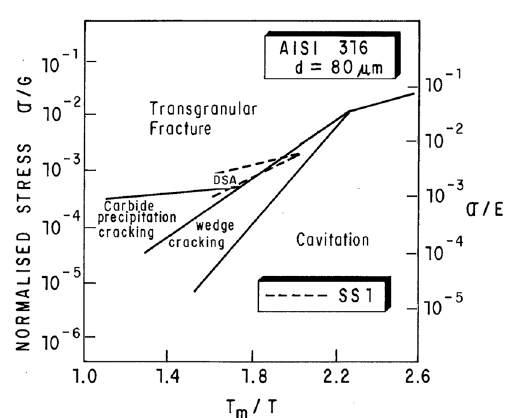
Figure 9. Model-based map for AISI type 316 stainless steel with grain size of 80